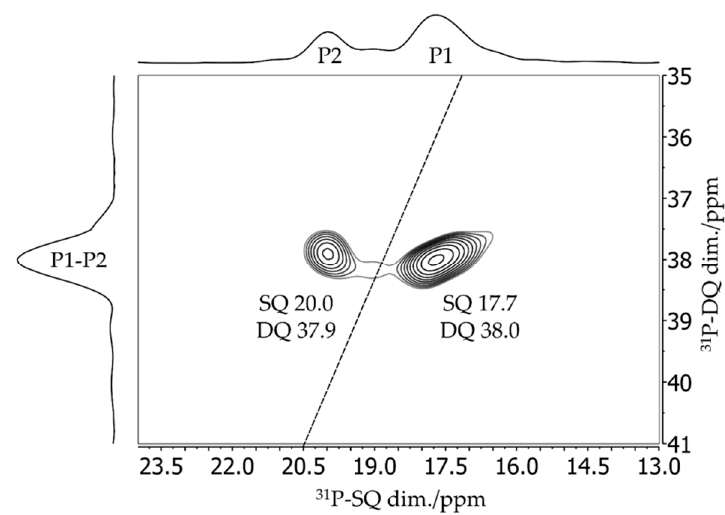
Figure 35. The 2D 31 P{ 1 H} CP/BaBa NMR spectrum of 9 , acquired with four BaBa blocks with four 90° pulses each (see Figure 10). 31 P chemical shifts in the single-quantum (SQ) and DQ dimensions are assigned to the resonances revealing P1–P2 correlation peaks, whereas no P1–P1 or P2–P2 autocorrelations are observed.